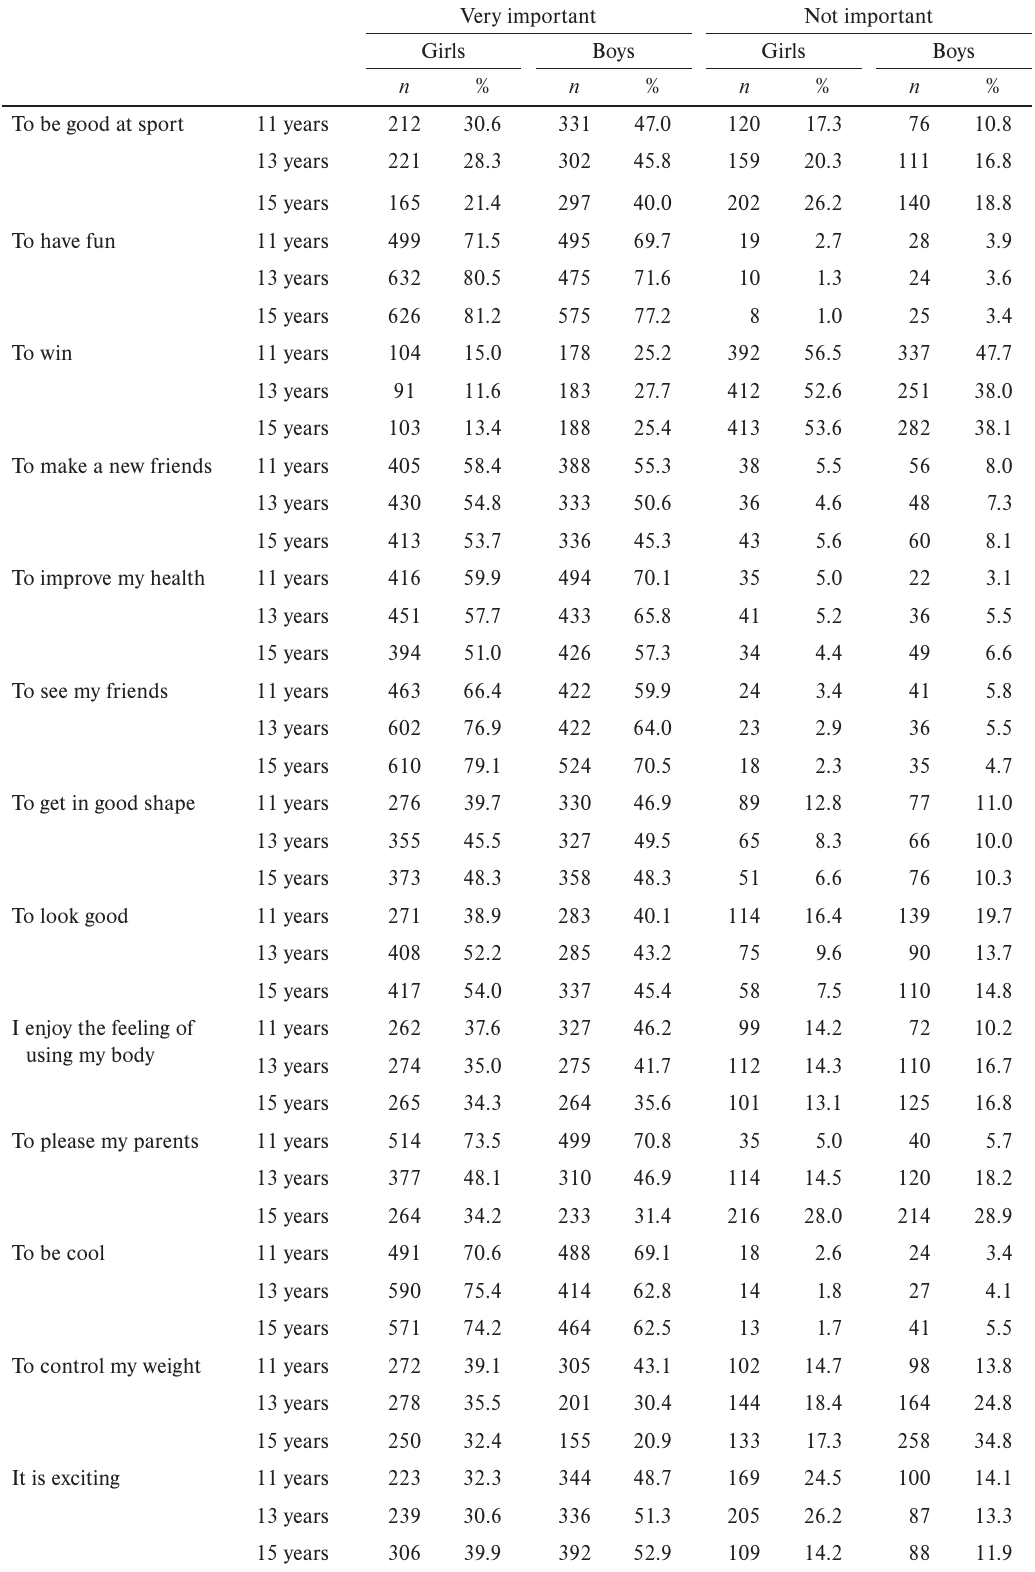
Motives for physical activity of Czech adolescents